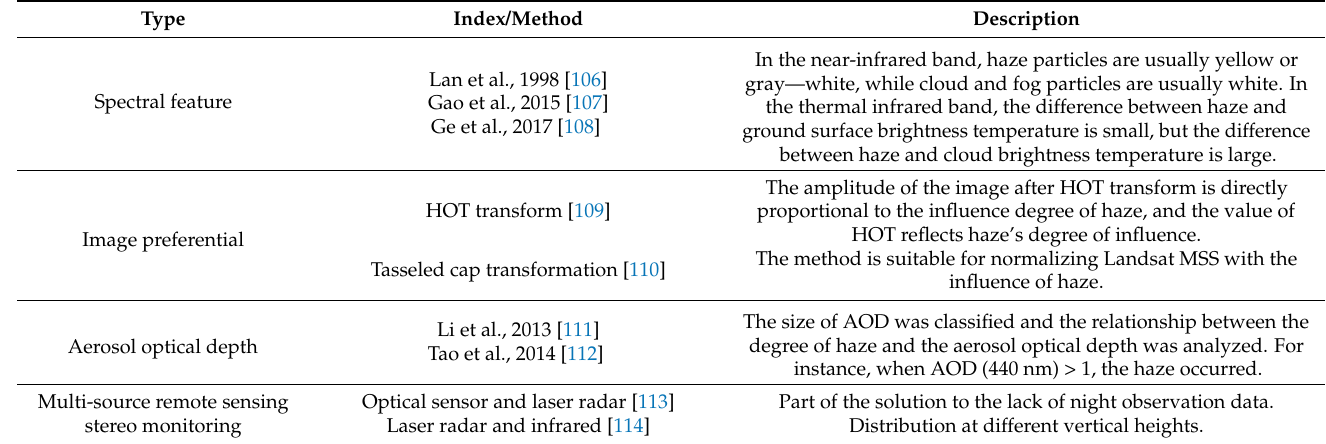
Table 6. Information extraction for haze.